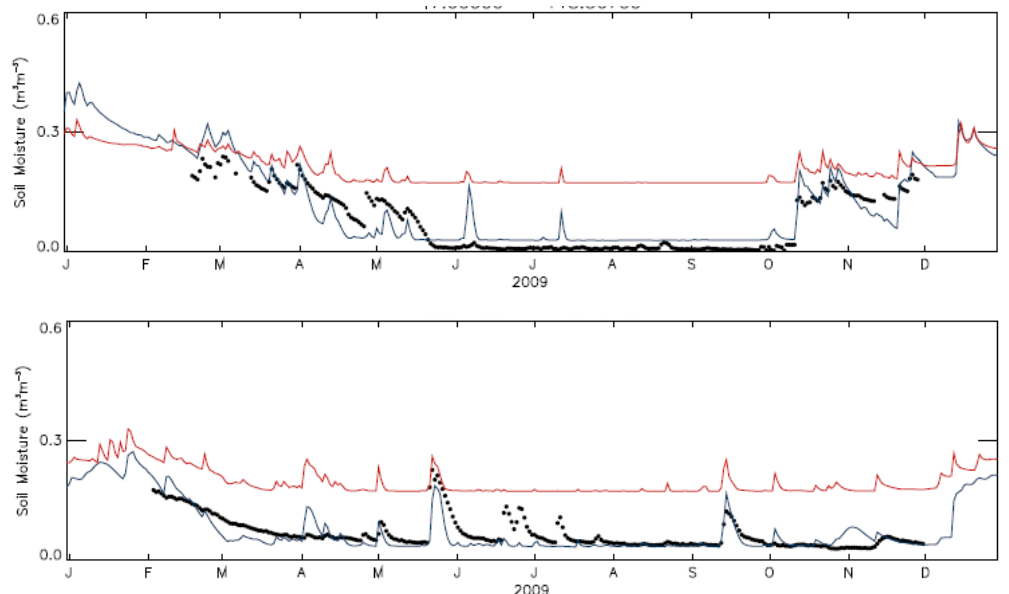
Figure 8. Evolution of volumetric soil moisture for the year 2009 at a site in Utah (latitude 47.000, longitude − 118.567, top panel) and Wash- ington (latitude 39.017, longitude − 110.167, bottom panel). In situ observations are in black, ERA-Interim is in red, and ERA-Interim/Land estimates in